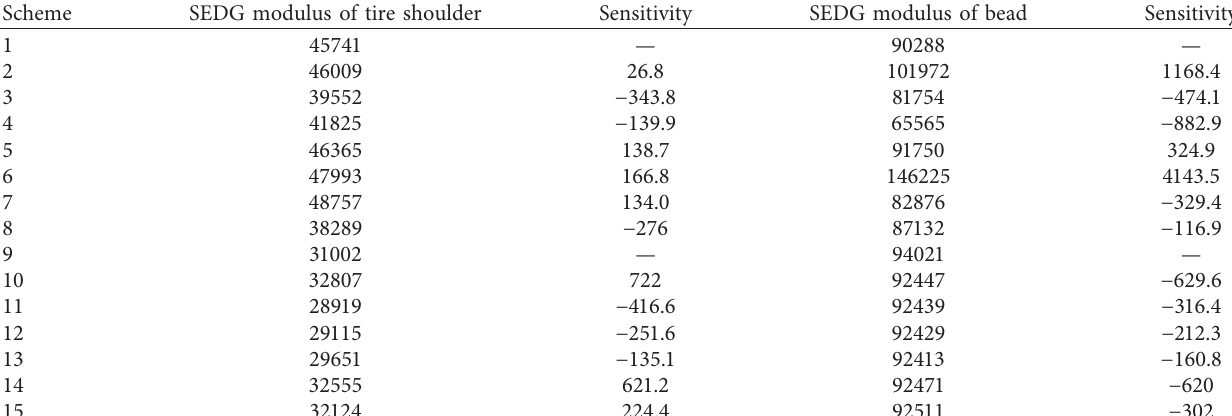
Table 4: Results of structural sensitivity analysis.